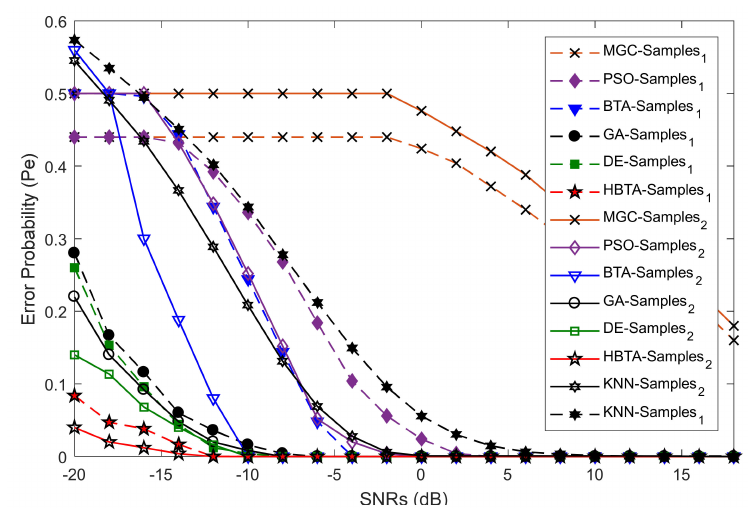
Figure 19. Error probability vs. SNRs in the presence of AY-AYC users with sensing samples 1 (280) and samples 2